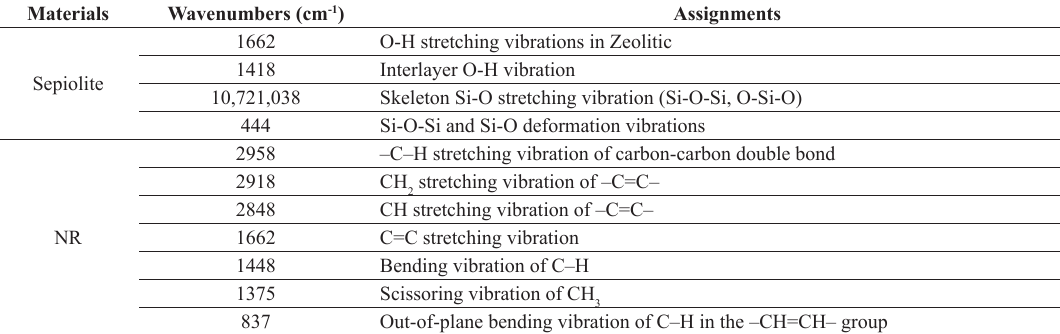
Table 3. Wavenumbers and their corresponding assignments of FTIR spectra observed in this study 12,13 . Materials Wavenumbers (cm -1 )